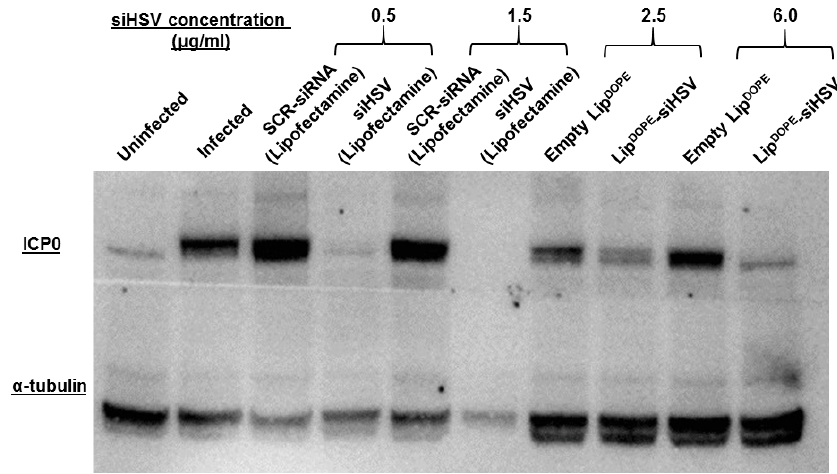
Figure 9. The expression levels of ICP0, following pre-treatment of HaCaT cells (keratinocytes) in- fected with HSV-1 (Western blot). Treatment groups: Lip DOPE -siHSV, empty Lip DOPE, and scrambled- siRNA (SCR-siRNA transfected by lipofectamine) served as negative controls, and siHSV (transfected by lipofectamine) served as positive control, in comparison to uninfected cells and untreated infected cells. Following 48 h of treatment, the cells were infected with HSV-1 (5 × 10 4 PFU) for 16 h and lysed. Cell lysates were separated in a gel and transferred onto a membrane incubated with primary antibodies α -tubulin and HSV-1 ICP0.